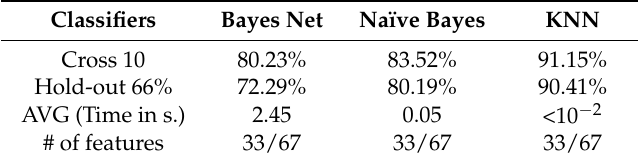
Table 3. Results using statistical features for Secure Password DB 150.